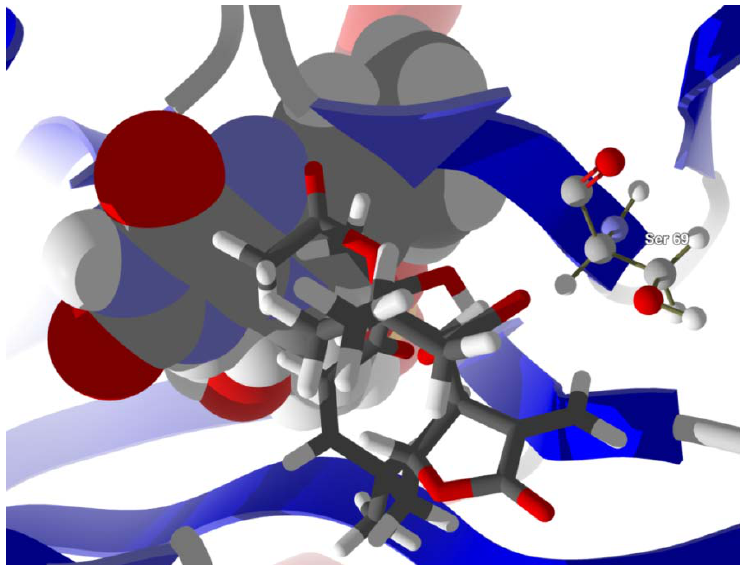
Figure 8. Lowest-energy docked pose of neurolenin B with L. major dihydroorotate dehydrogenase (LmajDHODH, PDB 3mhu). The cofactor, riboflavin monophosphate, is shown as a space-filling structure.